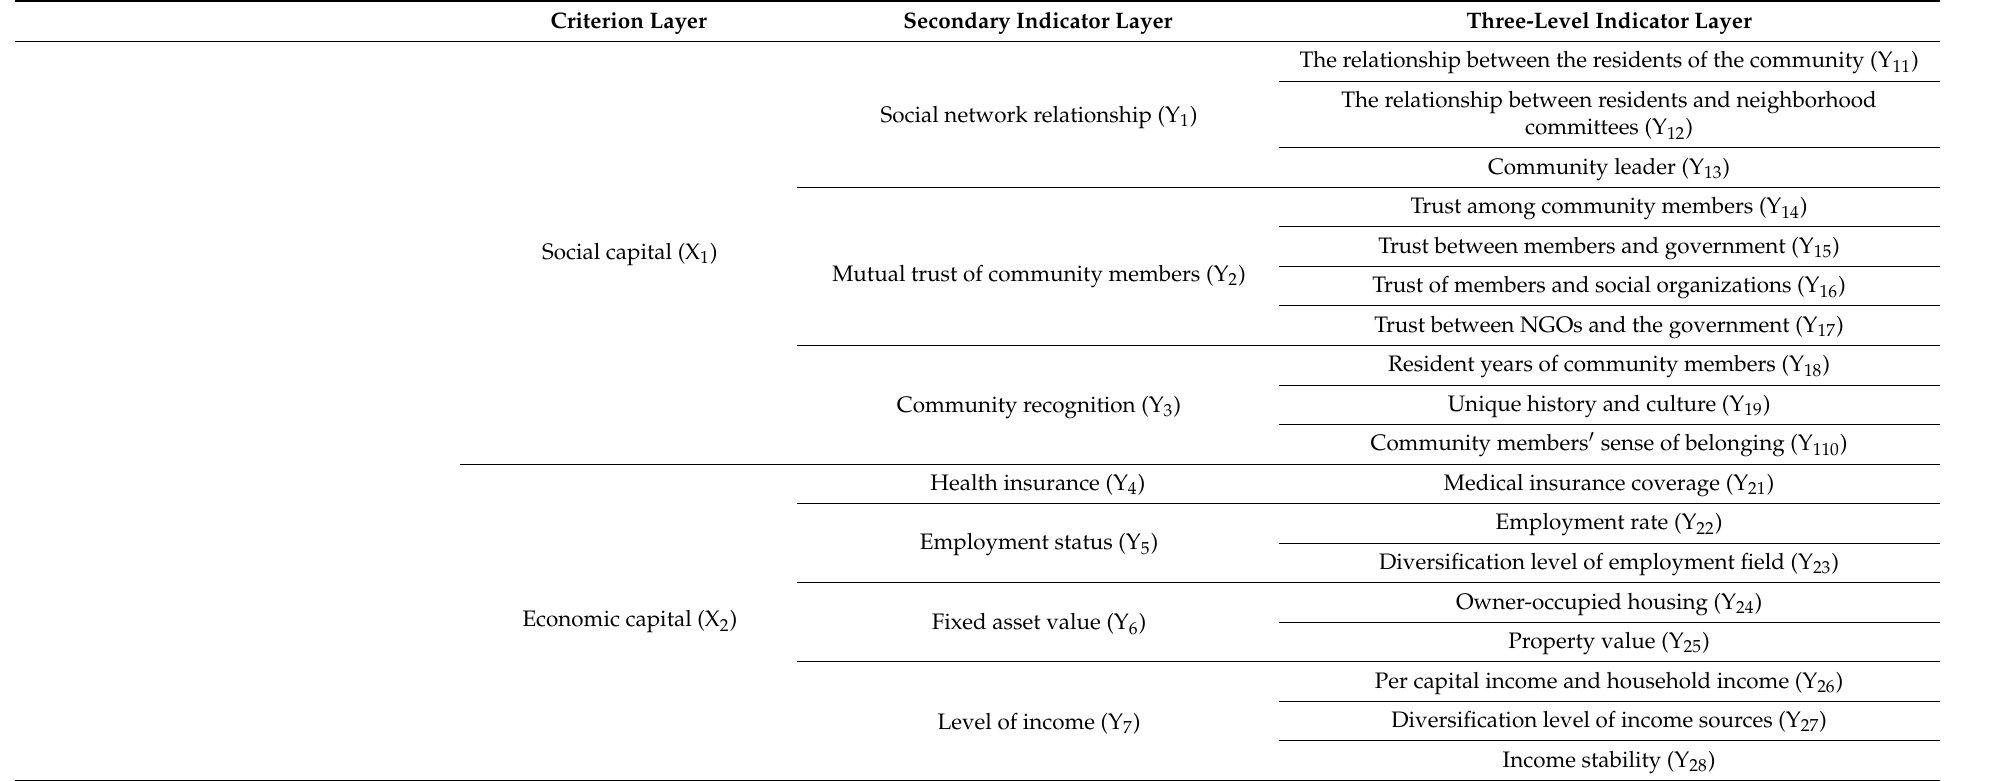
Table 2. Multiple influencing factors of urban community resilience to